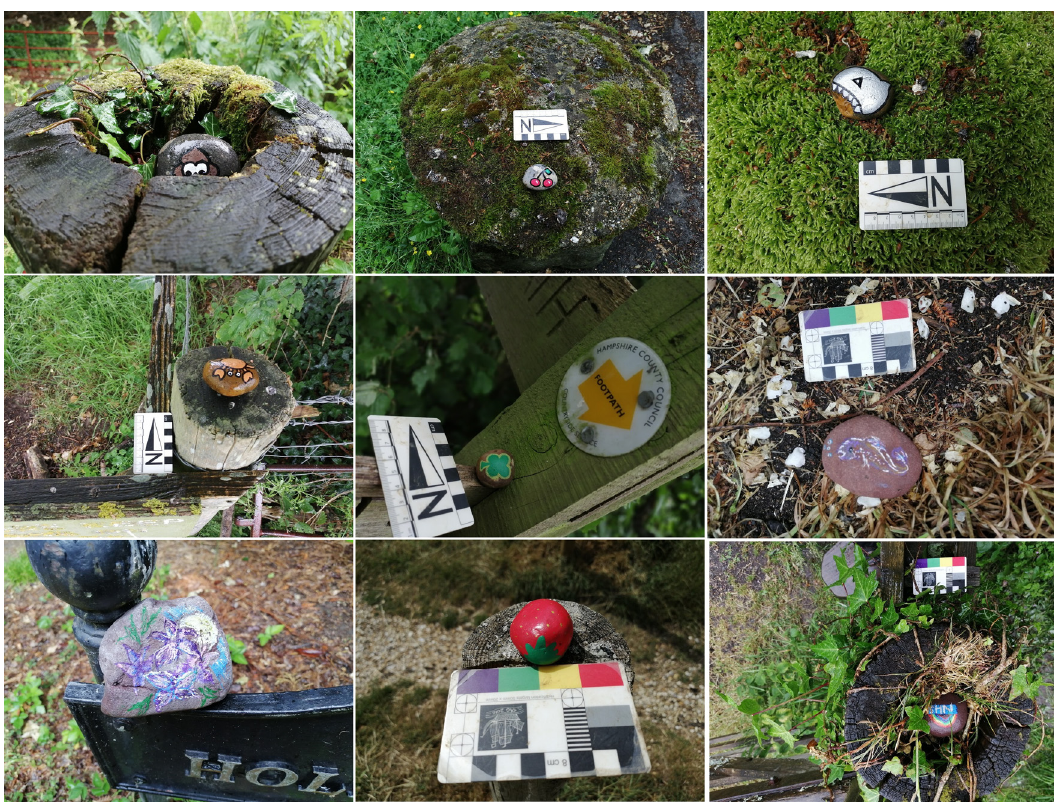
Figure 17: Painted pebbles in and around a Test Valley village and along its public rights of